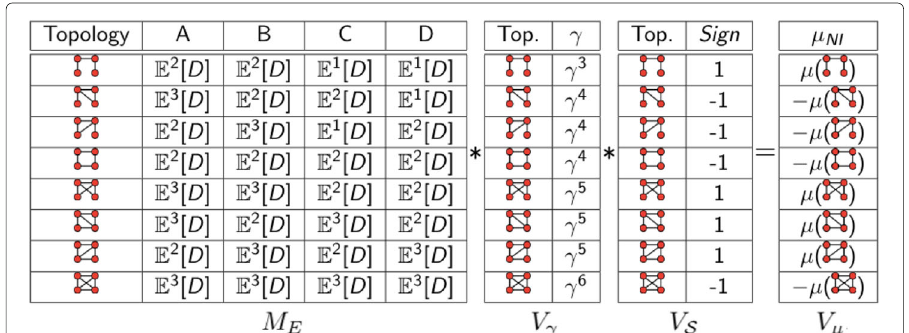
Fig. 11 The product between the matrix of moments M E , where the order of moments are given by the corresponding entries in M D (Fig. 10b), the gamma vector V γ of the powers of γ , where the exponents are the number of edges of each motif in the TIAS T of the 4-nodes path Fig. 10a, and the sign vector V S , containing the signs of all motifs in T gives as result the vector V μ of non-induced occurrence probabilities of all motifs in